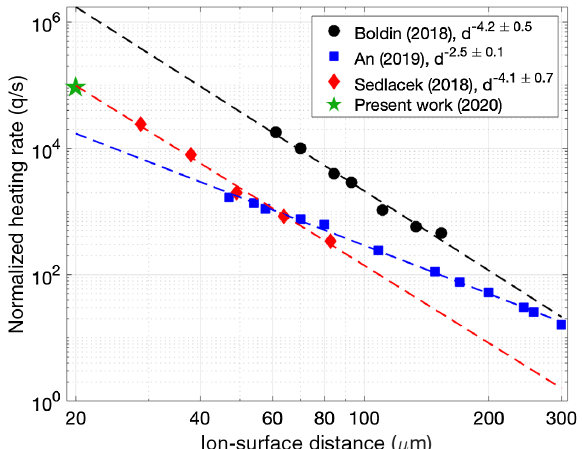
FIG. 4. Heating rate as a function of the ion-surface distance. The heating rate has been normalized for ion mass and secular motional trap frequency. We plot our data as the green star compared to previously published data from Refs. [14] (black circles), [24] (blue squares), and [15] (red diamonds). The scaling of each fit is indicated in the legend. Data are reprinted with permission from the authors of Ref. [24]. silicon nitride waveguide. Figure 3 shows the heating rate at 10 - μ m increments over a range of 80 μ m between the loading hole and the dielectric output grating. Remarkably, there is no measurable change in heating rate even when the ion is positioned directly above the dielectric output grating at a height of 20 μ m. The mean heating rate across the chip is 0 . 78 (cid:1) 0 . 05 q/ms.